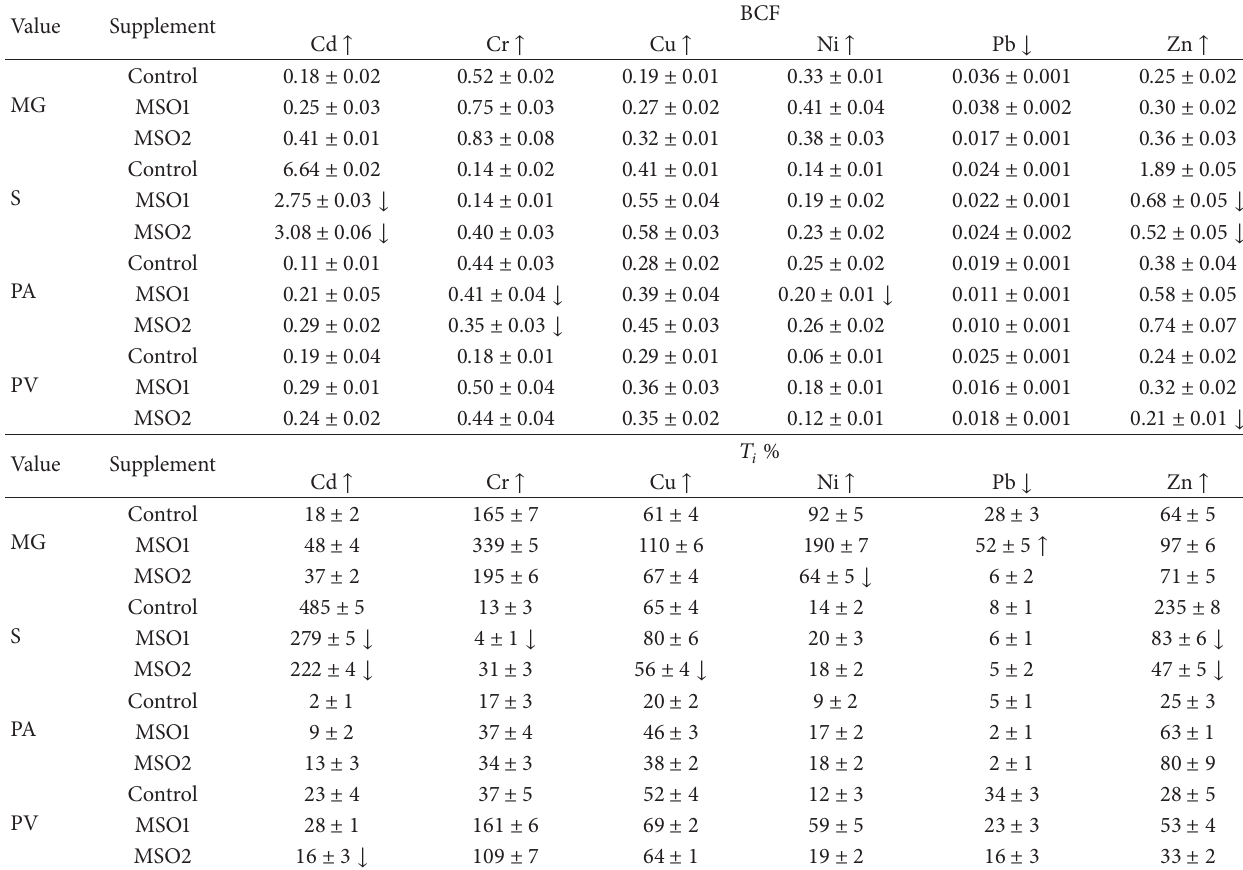
Table 4: Bioconcentration factor (BCF) and translocation index ( 𝑇 𝑖